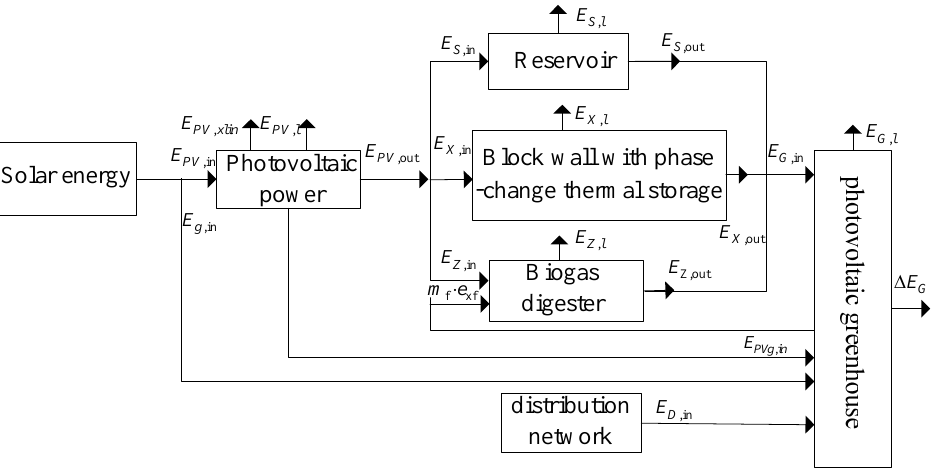
Figure 2. Photovoltaic greenhouse facility agricultural micro energy network exergy analysis diagram.